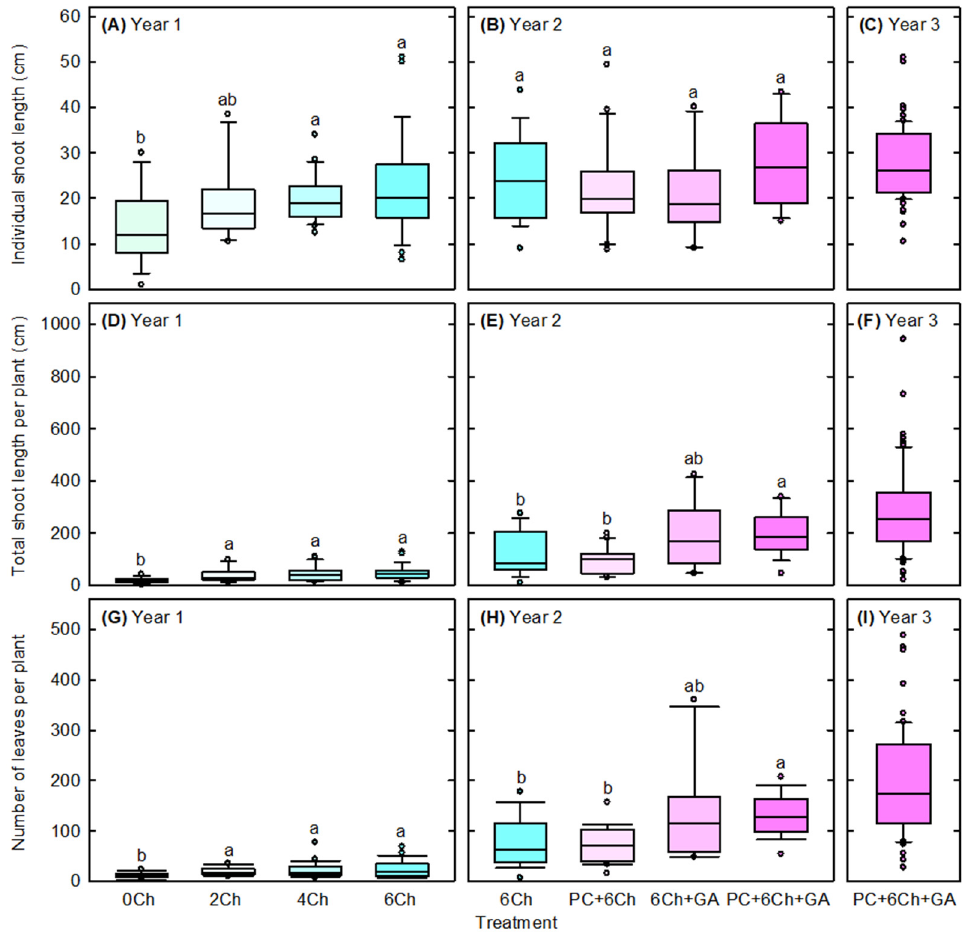
Figure 4. Length of individual shoots on peony plants in ( A ) Year 1, ( B ) Year 2 and ( C ) Year 3; the total length of shoots per plant in ( D ) Year 1, ( E ) Year 2 and ( F ) Year 3; and the number of leaves per plant in ( G ) Year 1, ( H ) Year 2 and ( I ) Year 3. ‘0Ch’, ‘2Ch’, ‘4Ch’ and ‘6Ch’ = 0, 2, 4 or 6 weeks of chilling at 4 °C, respectively; ‘PC’ = pre-treatment from 20 °C to 8 °C prior to chilling; ‘GA’ = GA 3 treatment after chilling. Medians are presented with 25th and 75th percentiles (boxes), 10th and 90th percentiles (whiskers), and outliers (circles). Medians in the same year with different letters are significantly different (Kruskal–Wallis and Dunn’s tests with Bonferroni corrections; p < 0.05, n = 18–65). Plants that received 2, 4 or 6 weeks of chilling in Year 1 had greater total shoot lengths than unchilled plants (Figure 4D). Plants that received the full treatment combination of pre-treatment at cool temperatures, chilling and GA 3 in Year 2 had greater total